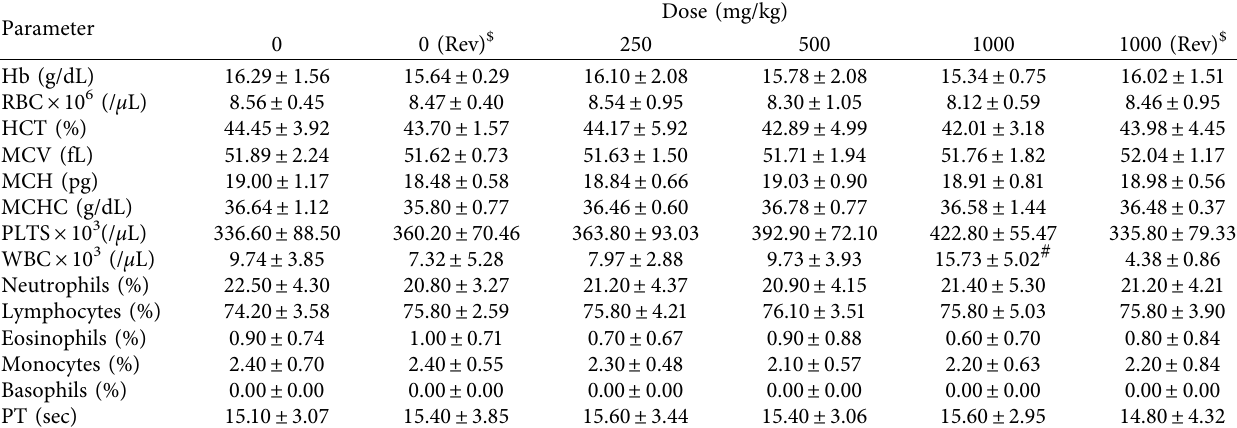
Table 4: Effect of GutGard on haematological parameters of female rats during 90D oral toxicity study.